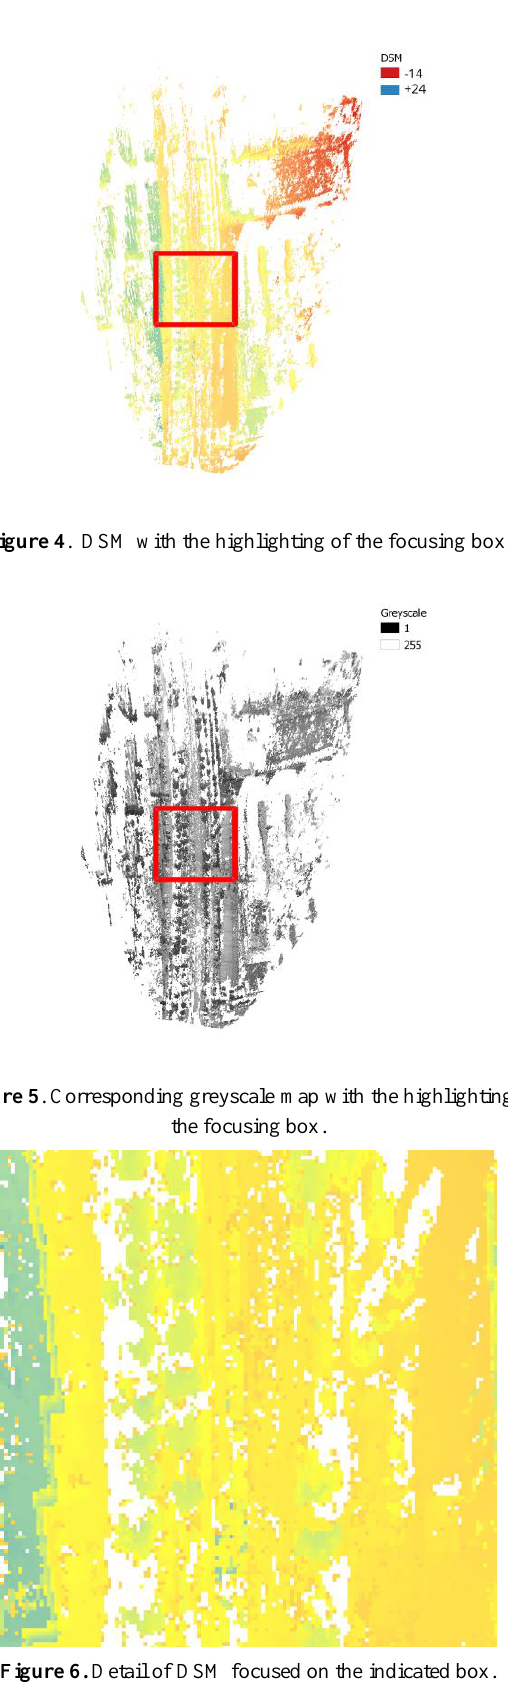
Figure 6. Detail of DSM focused on the indicated box.